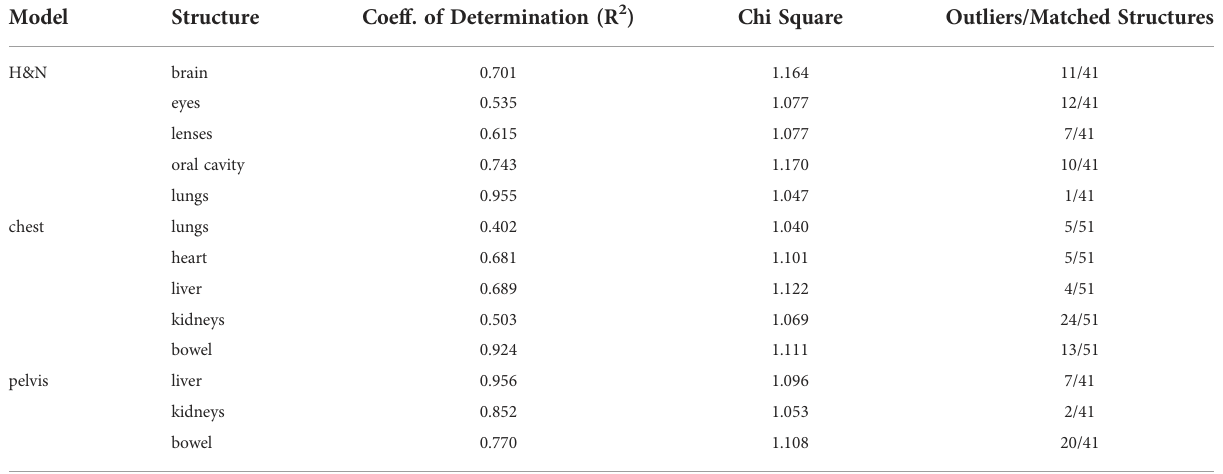
TABLE 1 Summary of model